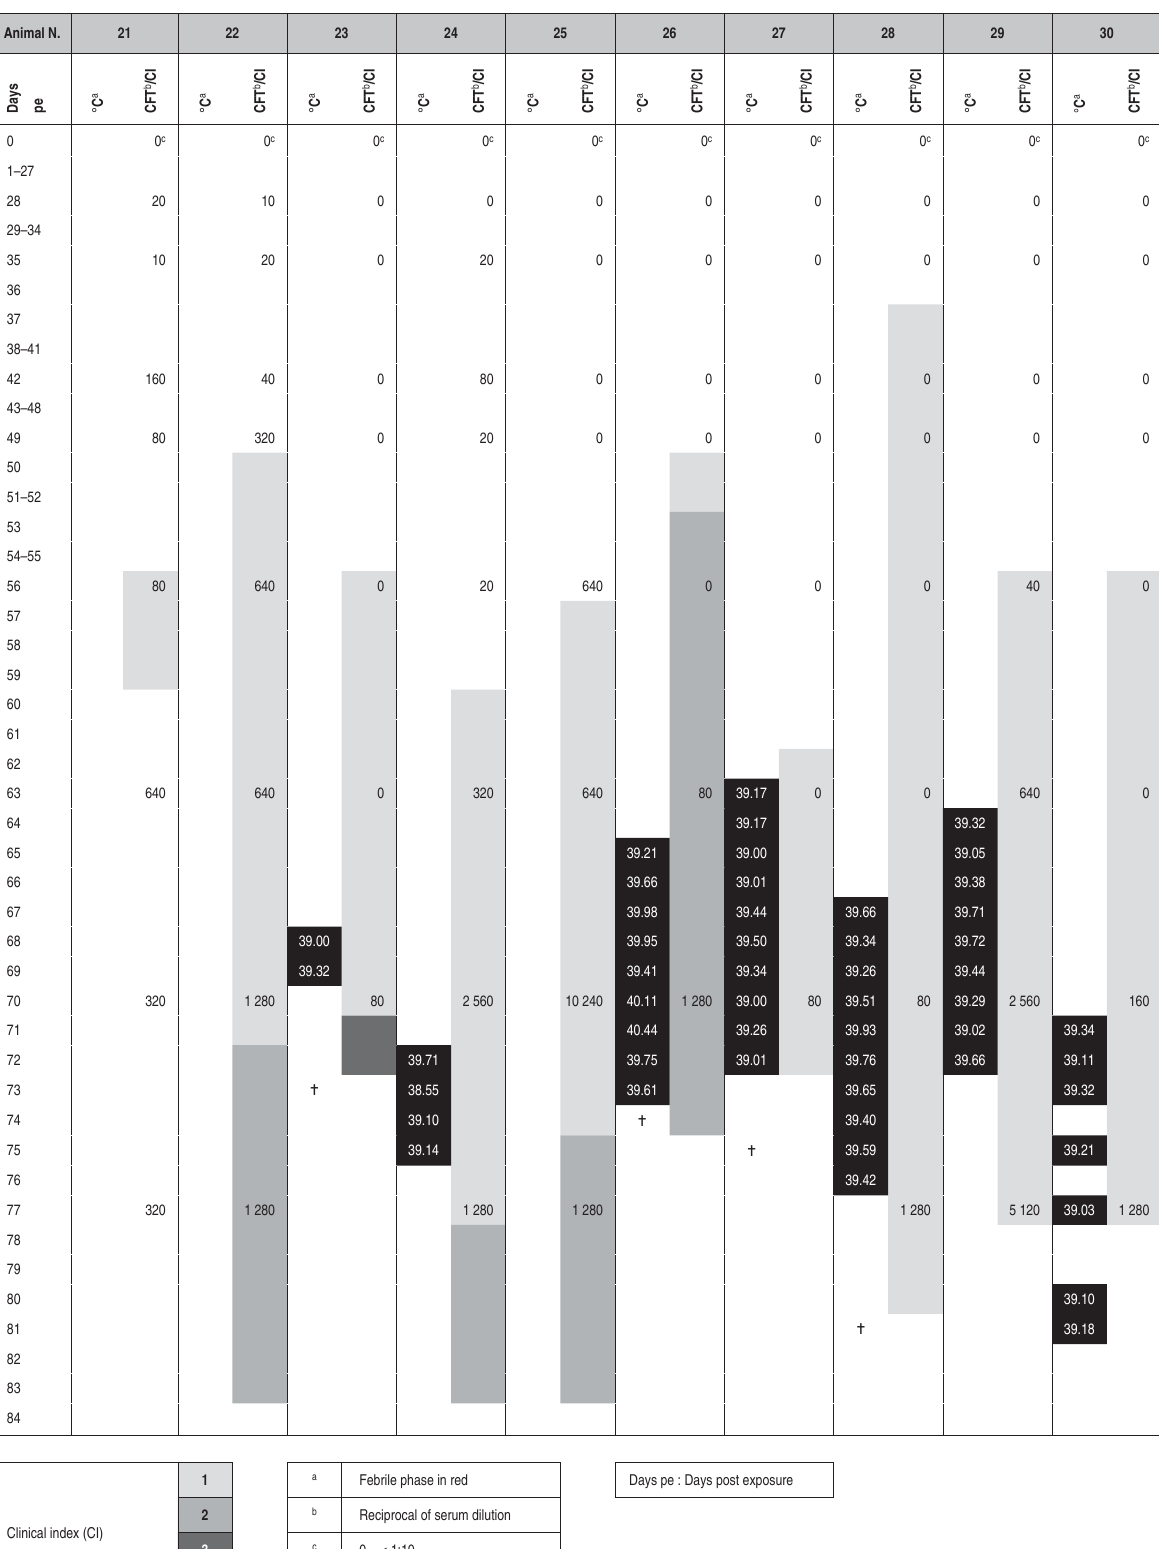
TABLE 4 Events following contact infection of cattle treated with CsA Animal